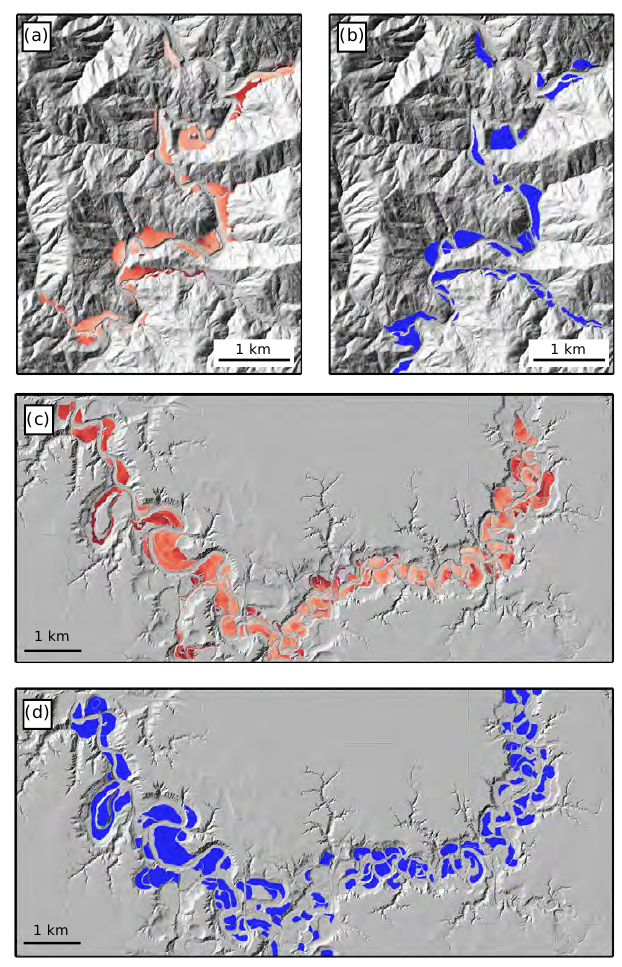
Figure 7. Shaded relief maps for the two field sites with lidar- derived DEMs showing a comparison between the predicted ter- races (red) and the digitised terraces (blue). The predicted terraces are coloured by elevation compared to the channel, where darker red indicates higher elevation. (a–b) South Fork Eel River, CA. Maxi- mum terrace height is 43m. (c–d) Le Sueur River, MN. Maximum terrace height is